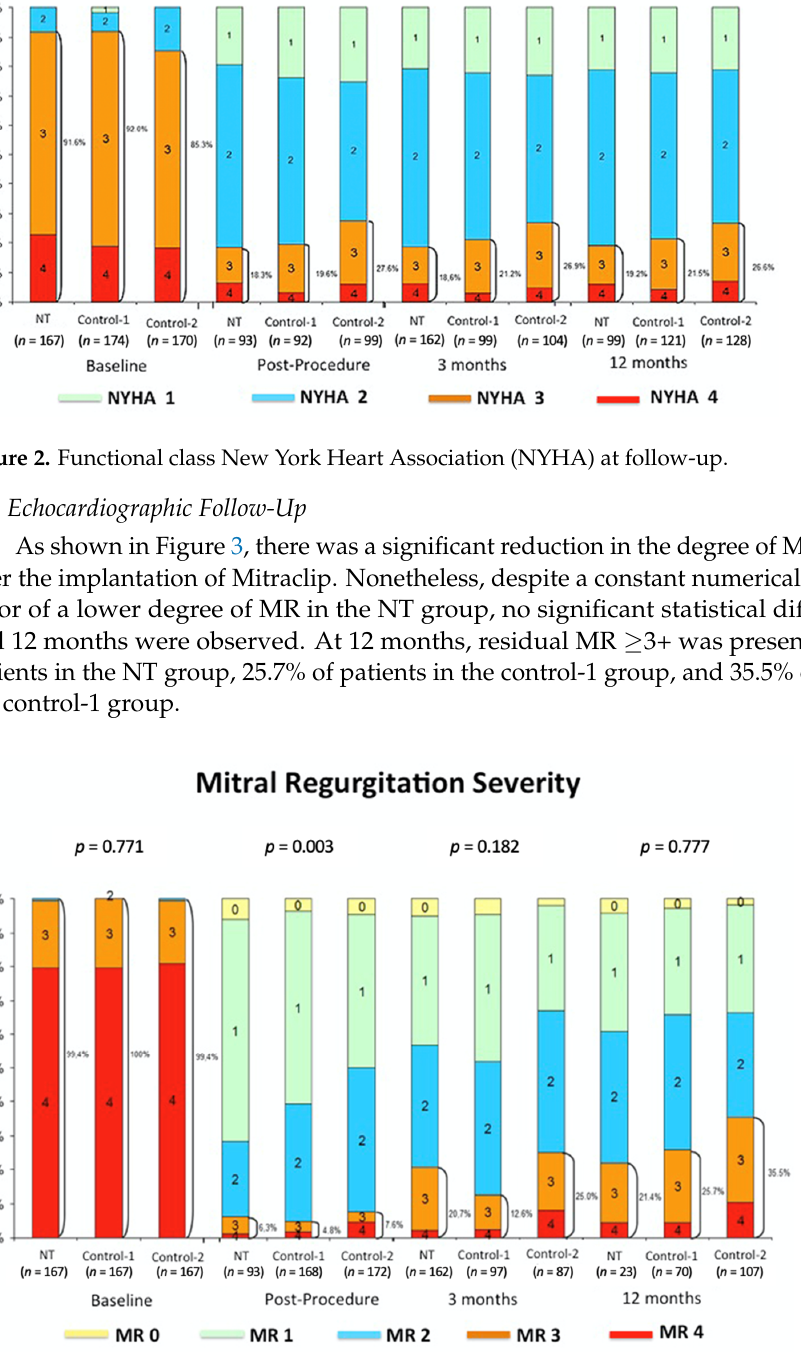
Figure 1. Freedom from death, surgery, and CHF admission.